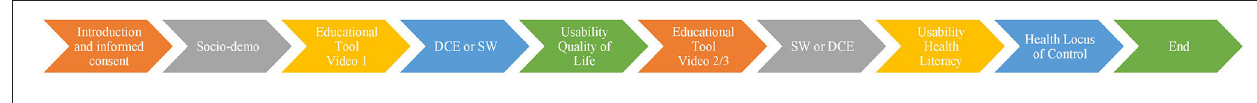
FIGURE 2 | Order of the questions in the survey. DCE, discrete choice experiment; SW, swing